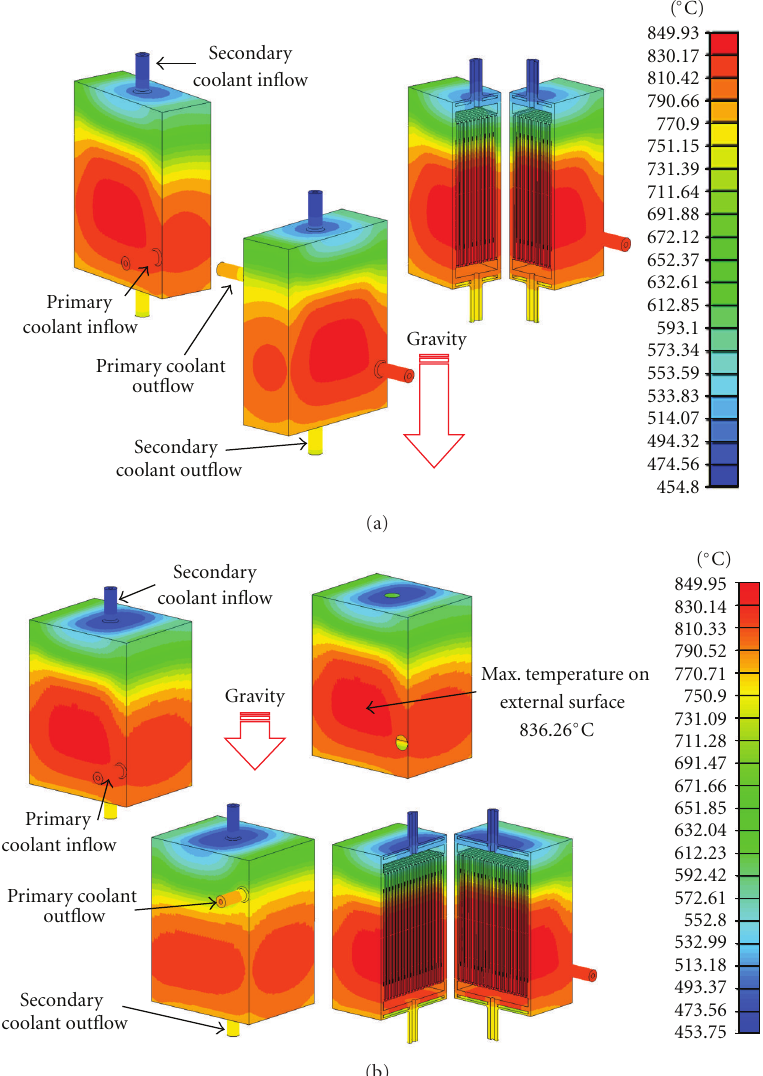
Figure 9: Temperature contours of outer PHEs: (a) 3kW class PHE prototype [6] and (b) 10 kW class PHE prototype [12].